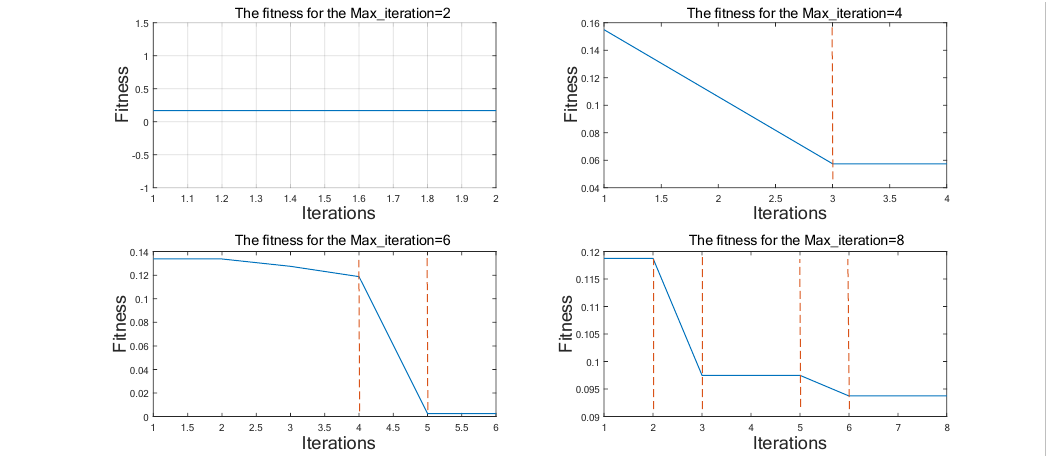
Figure 10. The adaptive curve of different iteration